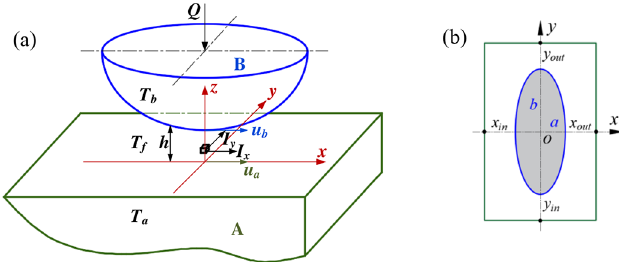
Fig. 1. Ellipsoid-plate contact model: (a) schematic of ellipsoid- plate contact, and (b)